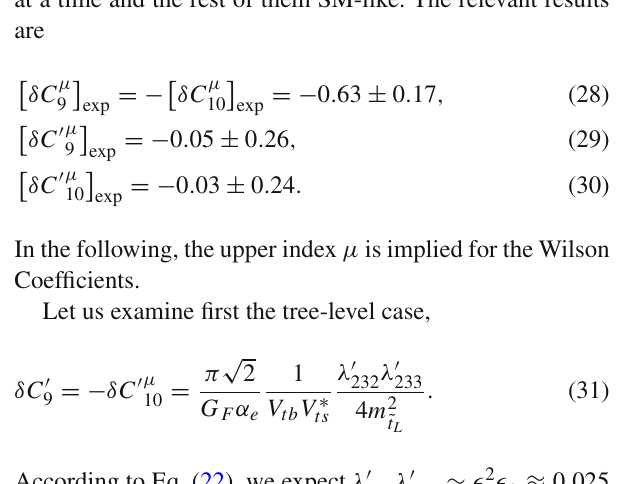
at a time and the rest of them SM-like. The relevant results